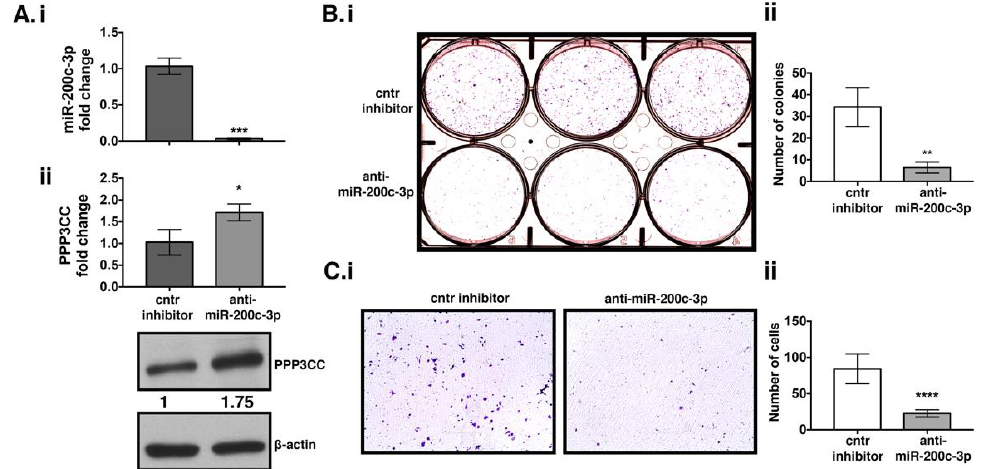
Figure 3. miR-200c-3p inhibition in EOC cells decreases colony forming and migration capacity. UWB 1.289 + BRCA1 cell line was transfected for 144 h with miR-200c-3p inhibitor. ( Ai ): Expression of miR-200c-3p was performed by RT-qPCR. RNU6 was used as a reference gene. ( Aii ): PP3CC expression was assessed through RT-qPCR. GAPDH was used as a housekeeping gene. Fold change expression with respect to the controls was calculated in terms of 2 −ΔΔCt . Western blot (WB) analysis of PPP3CC expression. β-actin was used as a loading control. Values show the fold change in PPP3CC expression in anti-miR-200c-3p transfected cell line comparing to the control (cntr) inhibitor, by Image J densitometric analysis. ( Bi ): 144 h post-transfected cells were placed in a 6-well plate and stained with crystal violet after 10 days to estimate colony formation ability ( Bii ): Graph shows the average number of colonies in each well of the clonogenic assays, calculated with the count tool of PhotoshopCC2017. The experiments were performed in triplicates and were repeated at least twice. ( Ci ): Transwell migration assays at 144 h post-transfection show cells able to traverse the transwell membrane, colored in blue violet. ( Cii ): Graph shows the average number of migrated cells, calculated from each of the 6 selected areas and in each well, by using the count tool of PhotoshopCC2017. Magnification 10 × . The white scale bar indicates 400 µ m). Two-tailed unpaired t -test was applied for statistical significance, * p < 0.05, ** p < 0.01, *** p < 0.001, **** p <